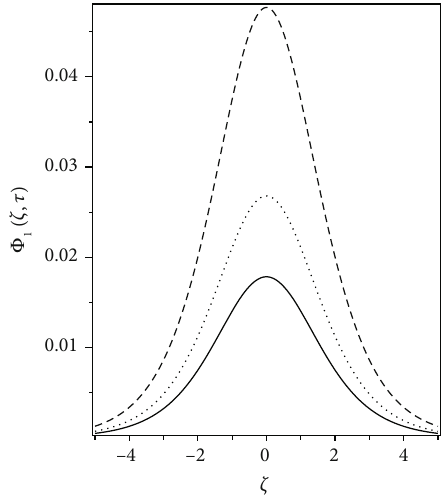
Figure 2: Compressibility variations with the coupling parameter from Reference [17].